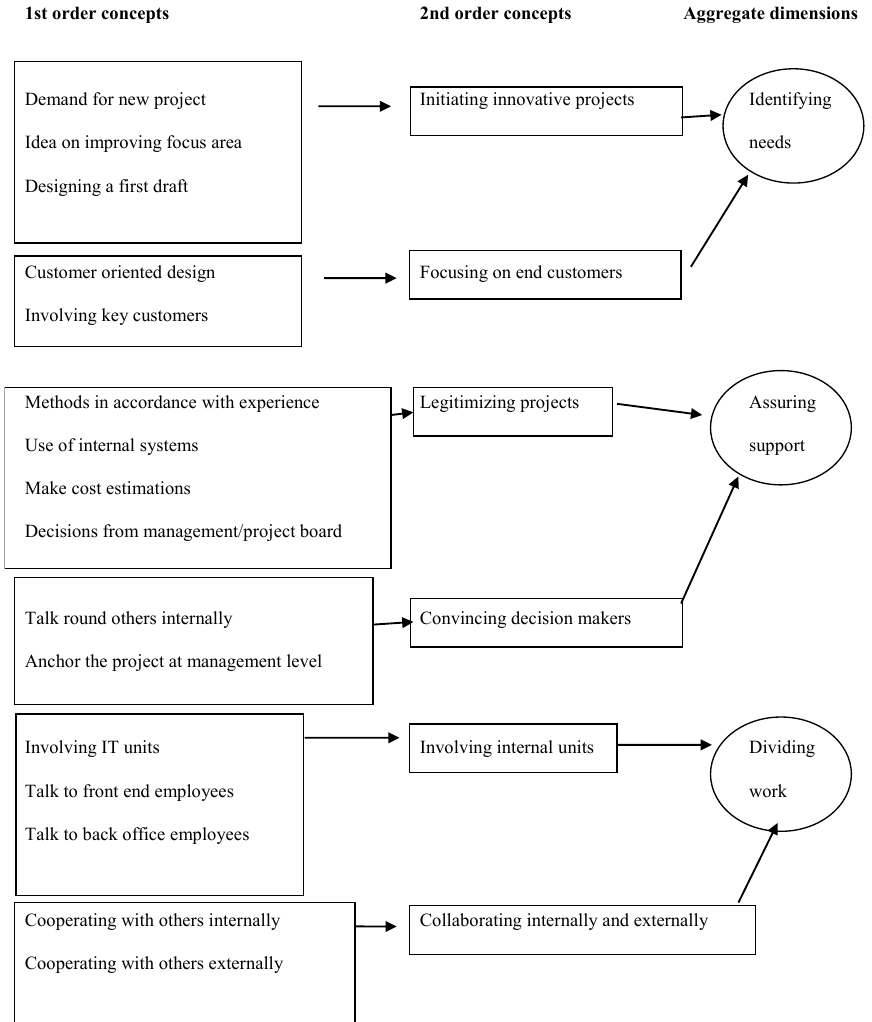
Fig. 1. NSD practices framework. Source: Author´s work Figure 1. NSD practices framework. Source: Authors’